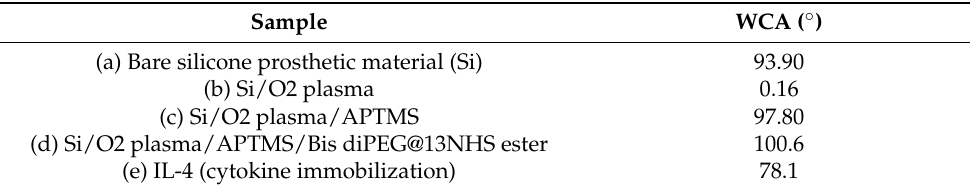
Table 2. Water contact angle measurements of silicone breast